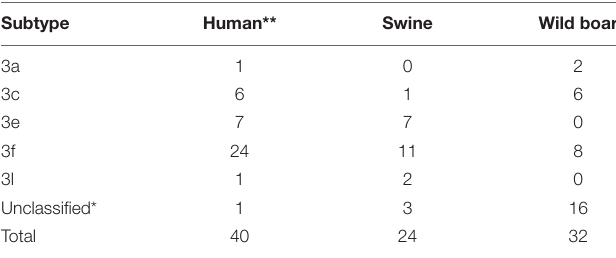
Italy (this study and downloaded at the NCBI database; collected from 2000 to